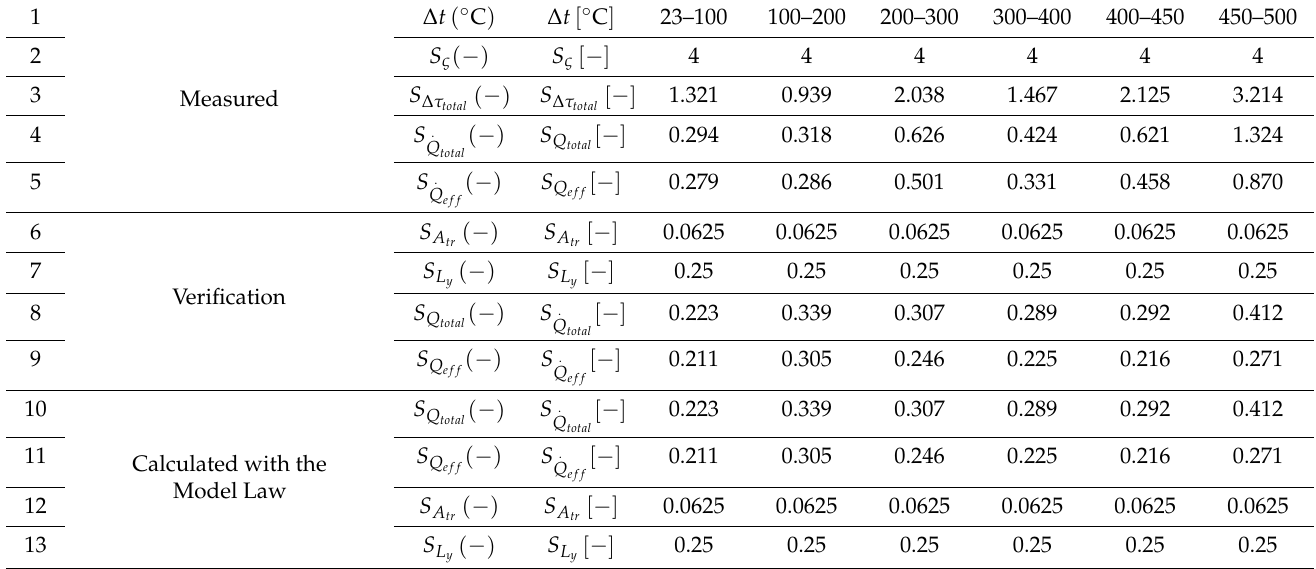
Table A9. The 1:4/1:1 painted model/prototype.